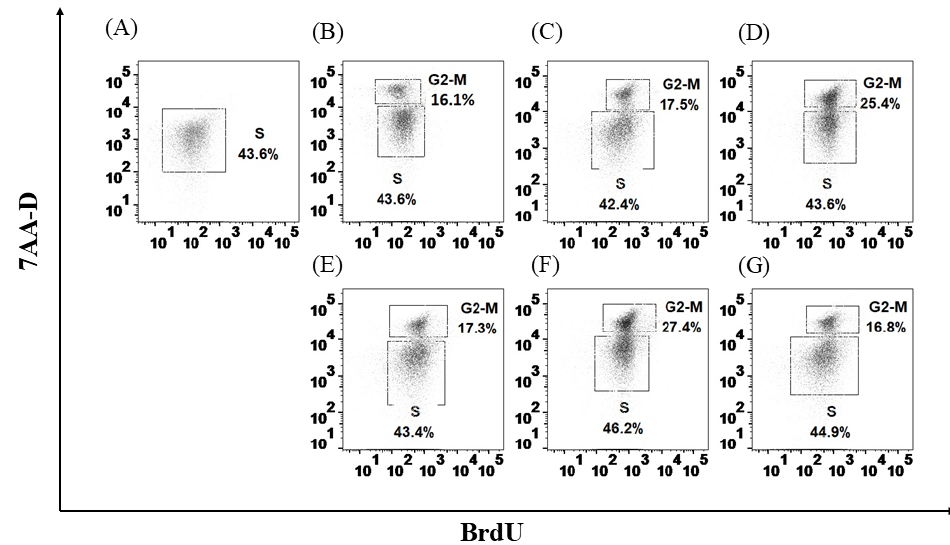
Figure 7. H. capsulatum yeasts affect HSPC proliferation. ( A ) Control, unstimulated HSPC; ( B ) HSPC + Pam3CysOH; ( C ) HSPC + LPS; (D ) HSPC + β -glucan; ( E ) HSPC + Pam3CysOH + H. capsulatum ; ( F ) HSPC + LPS + H. capsulatum ; ( G ) HSPC + β -glucan + H. capsulatum . Data represent the percentage of BrdU positive cells; results are from a representative experiment of three replicates.